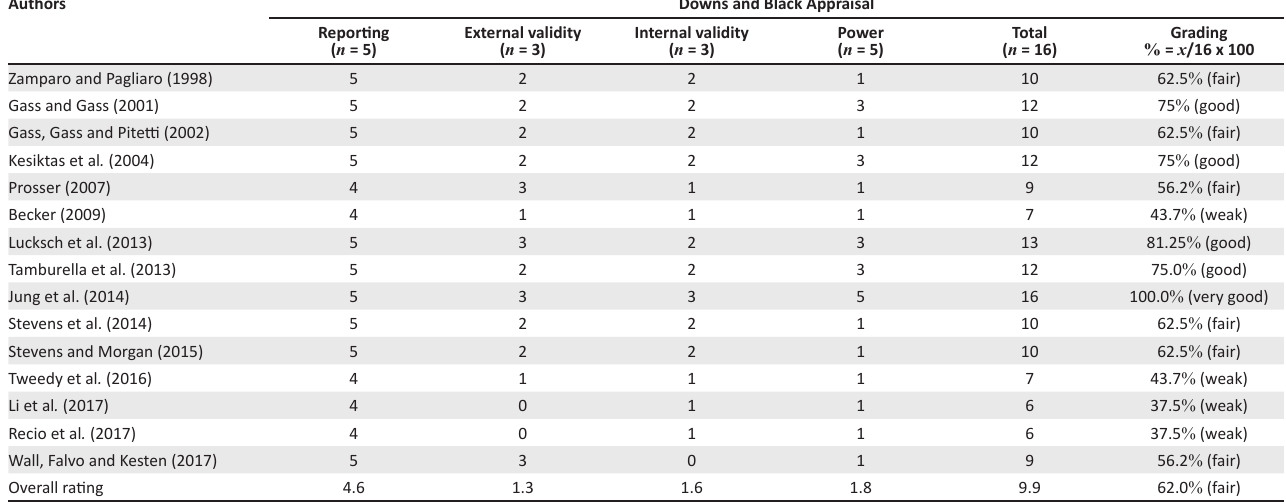
TABLE 1: Appraisal of records according to the modified Downs and Black Appraisal Scale.